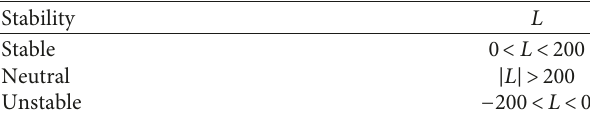
Table 3: Stability regimes and corresponding values of L